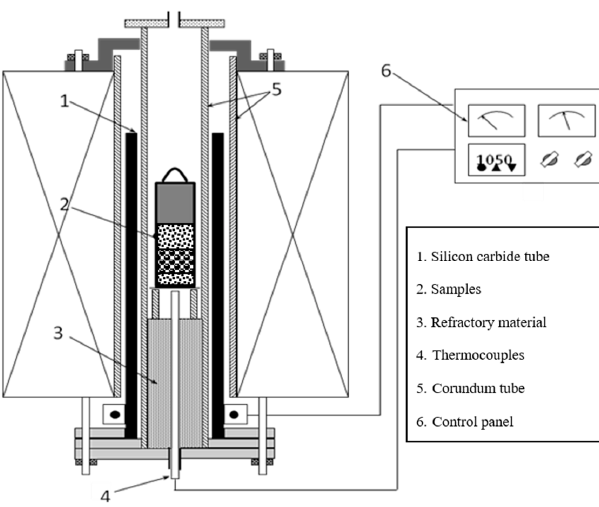
Figure 3. Schematic of vertical furnace for reduction.